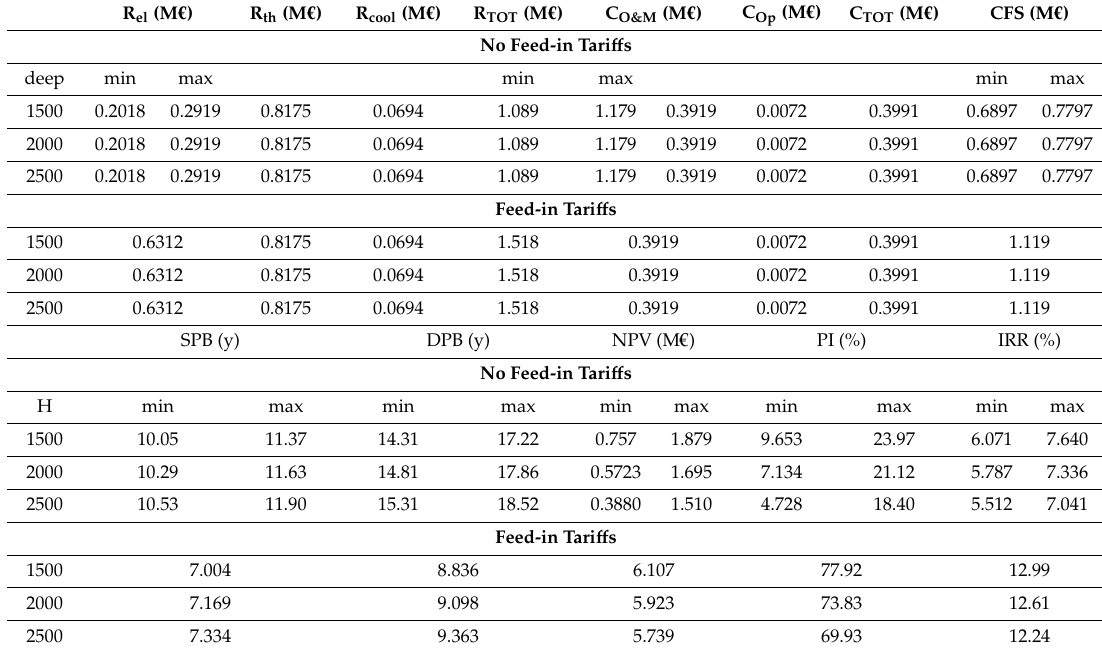
Table 7. Main results of the economic analysis (on a yearly basis).